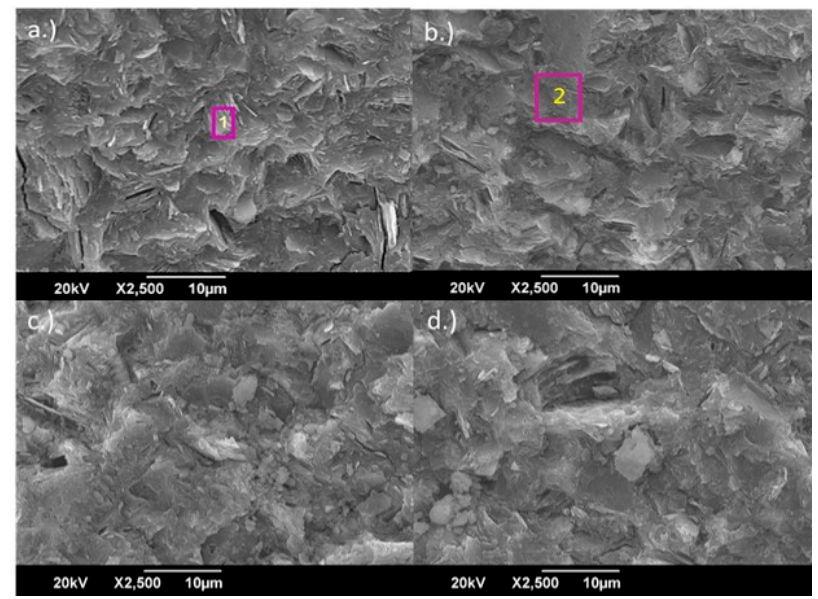
Figure 10. SEM micrographs. ( a ) GP at seven days, ( b ) GP 0 at 28 days, ( c ) GP 10 Ti at seven days, and ( d ) GP 10 Ti at 28 days.